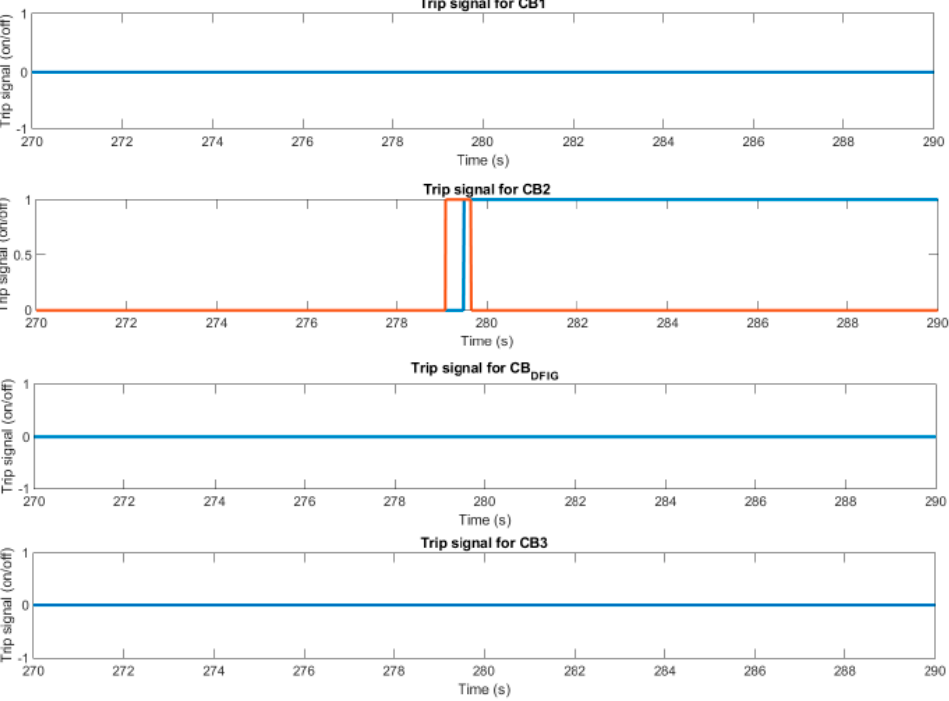
Figure 18. Trip signals received from protection IEDs simulating CBs operation in real-time for power system.